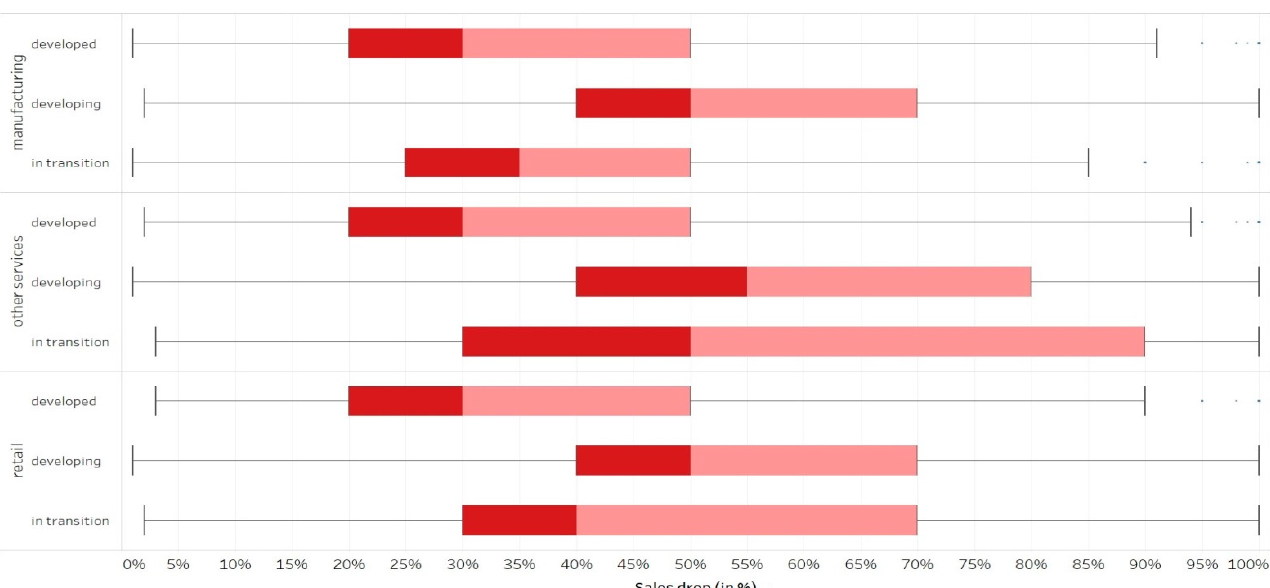
Figure 4. Distribution of the decline in sales by sector and region – dark red represents values between first quartile and Table 4. Logit binary model’s estimation results *.